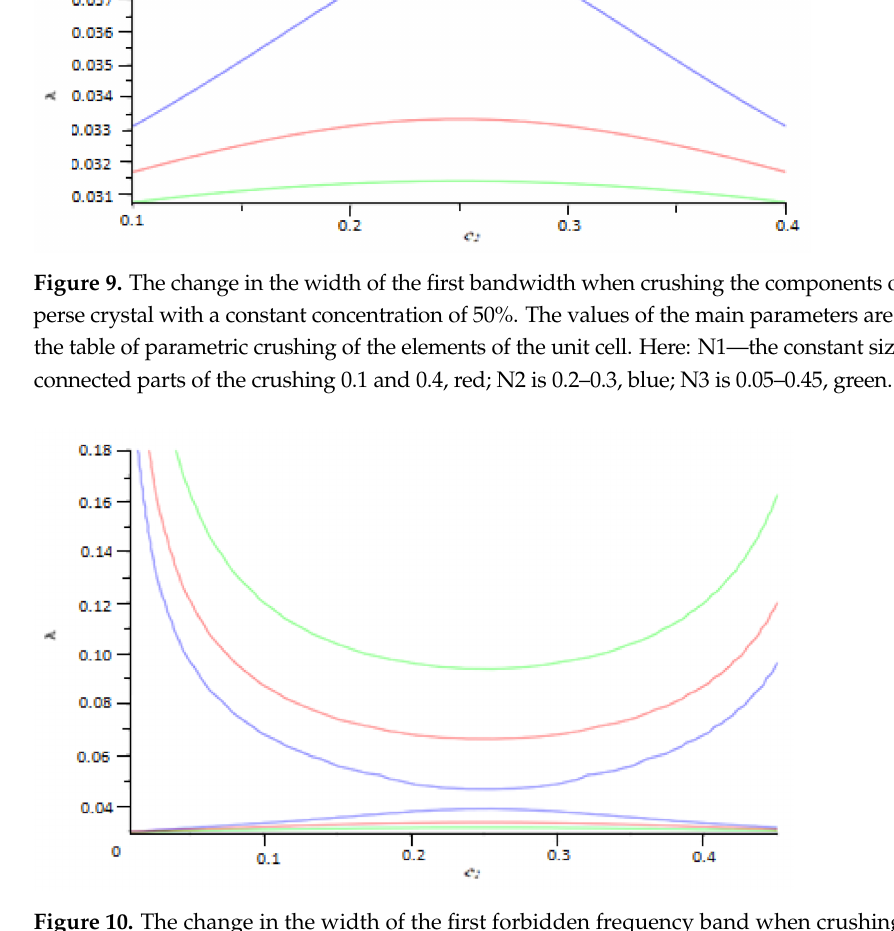
Figure 10. The change in the width of the first forbidden frequency band when crushing the compo- nents of a monodisperse crystal with a constant concentration of 50%. Here: N1—constant sizes of two connected parts of crushing 0.1 and 0.4, red; N2 is 0.2–0.3, blue; N3 is 0.05–0.45,